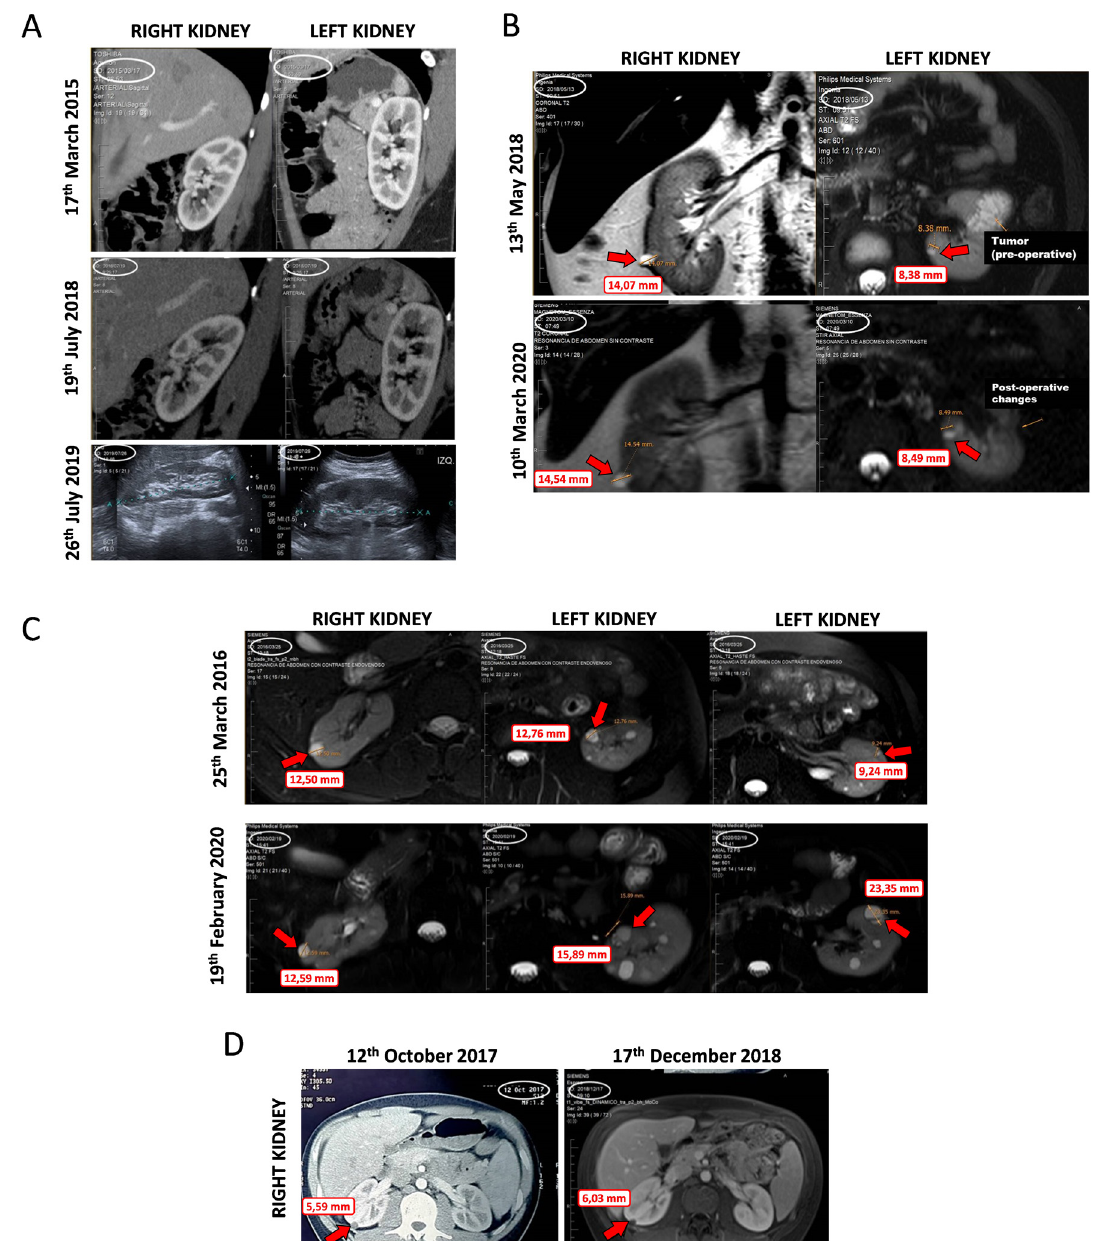
Figure 6. Different images of tumor and cystic lesions evolution in kidneys of VHL patients, before and during propranolol treatment. ( A ). Patient 1. Female who, after 36 months of treatment, shows no lesions. ( B ). Patient 2. Male, with a partial nephrectomy due to a solid and cystic lesion diagnosed as ccRCC and small bilateral cystic lesions detected. After 22 months of follow-up, the sizes of the cysts are similar without significant changes. No new tumor has appeared. ( C ). Patient 3. Male who underwent a bilateral partial nephrectomy before treatment and a tumor growth in his right kidney. No relapsing or new solid tumors have been detected since the treatment. Moreover, his left kidney showed two main cystic lesions, and none of them show surgical criteria, and multiple small bilateral cystic lesions remain. ( D ). Patient 4. Male, bearing three cystic lesions before propranolol treatment. These lesions remain stable after propranolol treatment.